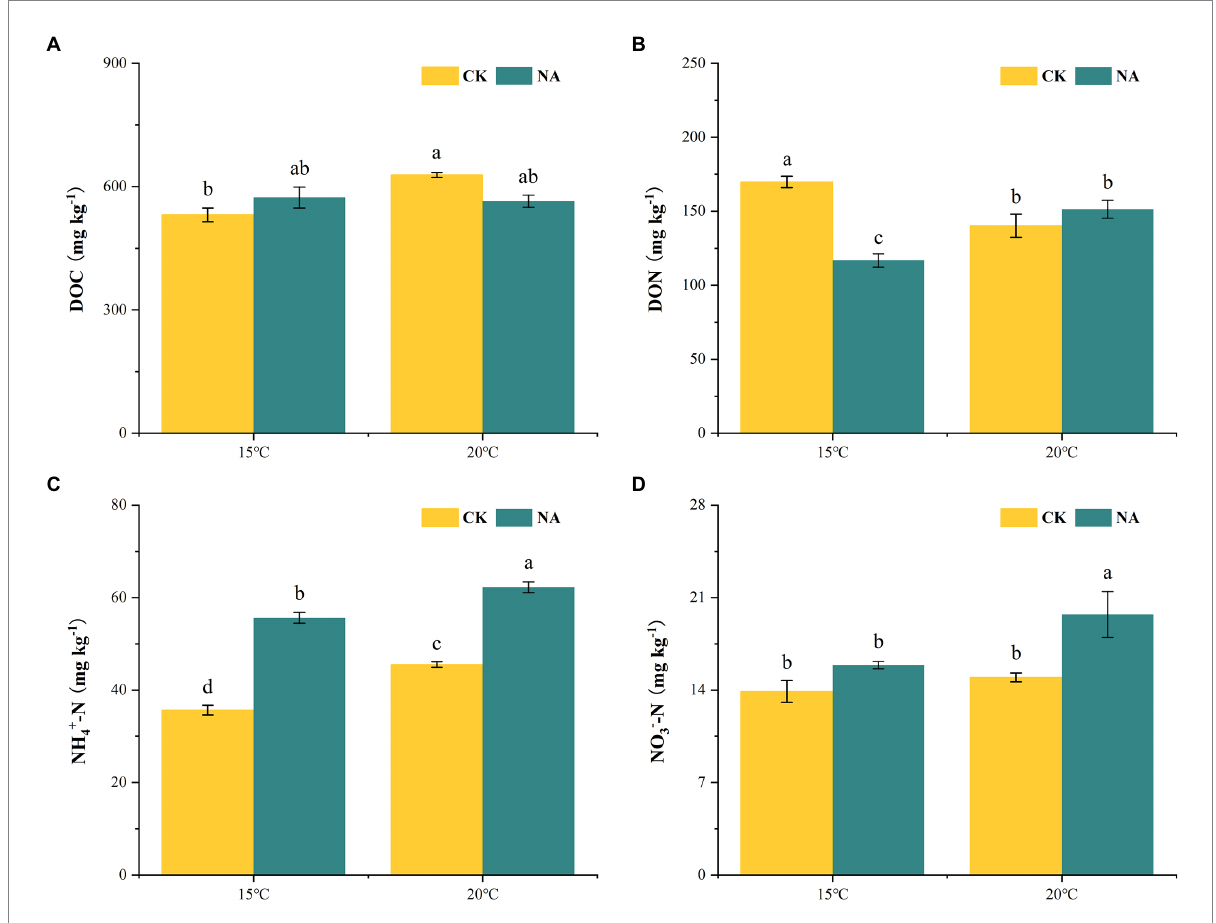
FIGURE 6 Effects of temperature rising and nitrogen addition on soil dissolved organic carbon (A) , dissolved organic nitrogen (B) , NH 4+ -N (C) , and NO 3 − -N (D) contents in peatland. CK, control; NA, add 50 mg N kg − 1 soil; DOC, dissolved organic carbon; DON, dissolved organic nitrogen; NH 4+ -N, ammonium nitrogen; NO 3— N, nitrate nitrogen. Different lowercase letters in the figure indicate significant differences in the means between different